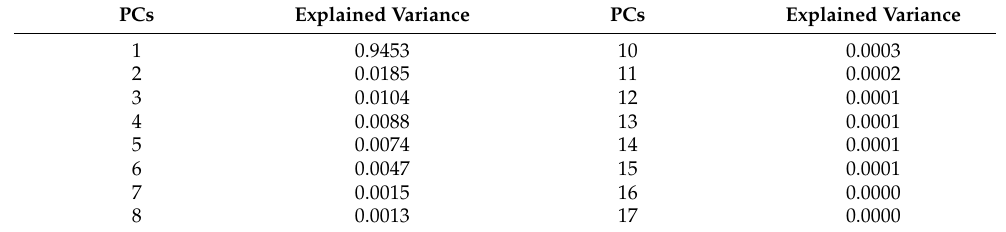
Table 8. The Amount of Each Measure for pre-COVID-19 with One-Day-Ahead Forecast.